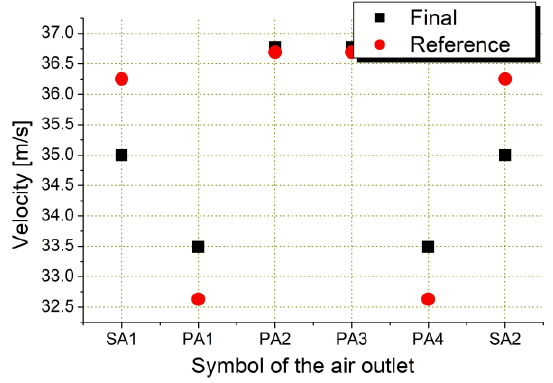
Fig. 9. Comparison of the outlet velocities for the reference design and the